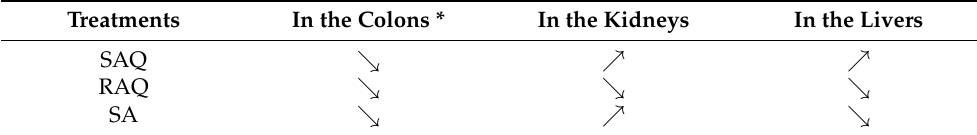
Table 1. Summary of the aqps alterations for the three treatments.